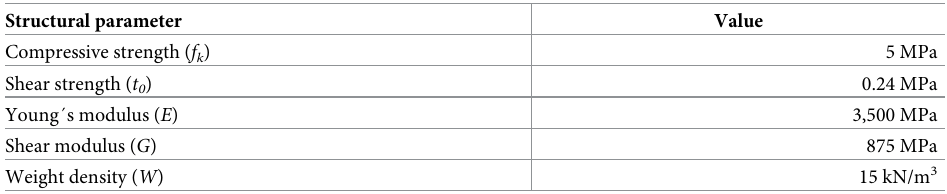
Table 1. Mechanical properties adopted for the brick masonry